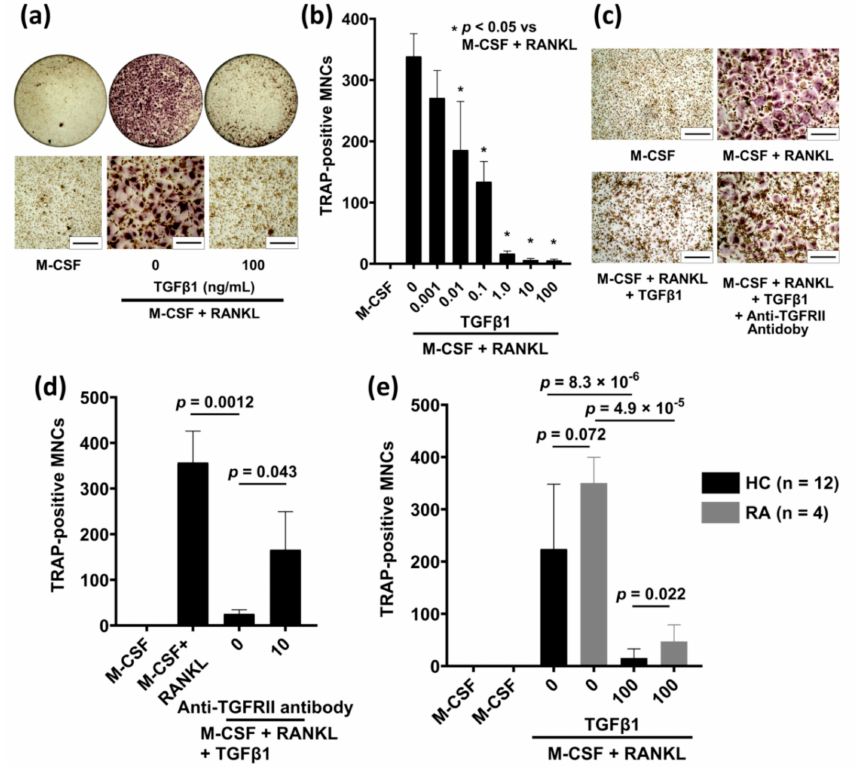
Figure 1. Inhibitory e ff ect of TGF β 1 on receptor activator of nuclear factor kappa-B ligand (RANKL)-induced osteoclastogenesis in human peripheral blood monocytes (PBMs). ( a , b ) PBMs were cultured with 50 ng / mL of macrophage-colony stimulating factor (M-CSF) and / or 100 ng / mL of RANKL in the presence of increasing concentrations (0–100 ng / mL) of TGF β 1, for 5–6 days, and then analyzed, using tartrate-resistant acid phosphatase (TRAP) staining. TGF β 1 significantly inhibited RANKL-induced osteoclast generation even at a low concentration of 10 pg / mL, and this inhibitory e ff ect increased in a dose-dependent manner. The inhibitory e ff ect of TGF β 1 reached a plateau at concentrations of ≥ 1.0 ng / mL. * p < 0 · 05 versus M-CSF + RANKL. ( c , d ) TRAP staining-based analysis of the e ff ect of anti-TGF β receptor II (TGFBRII) antibody on the inhibitory e ff ect of TGF β 1 on RANKL-mediated osteoclastogenesis in human PBMs. PBMs were pretreated with or without 10 µ g / mL of TGFBRII antibody for 5 min and then subjected to M-CSF and RANKL treatment in the presence or absence of TGF β 1. Anti-TGFBRII antibody significantly reversed the inhibitory e ff ect of TGF β 1. ( e ) Comparison of the inhibitory e ff ect of TGF β 1 on RANKL-stimulated osteoclastogenesis in PBMs obtained from healthy donors and untreated seropositive patients with rheumatoid arthritis (RA). During the culture, half the culture medium was replaced with fresh medium containing cytokines every three days. Representative microphotographs are shown. Scale bar = 50 µ m. Data are presented as the mean ± standard